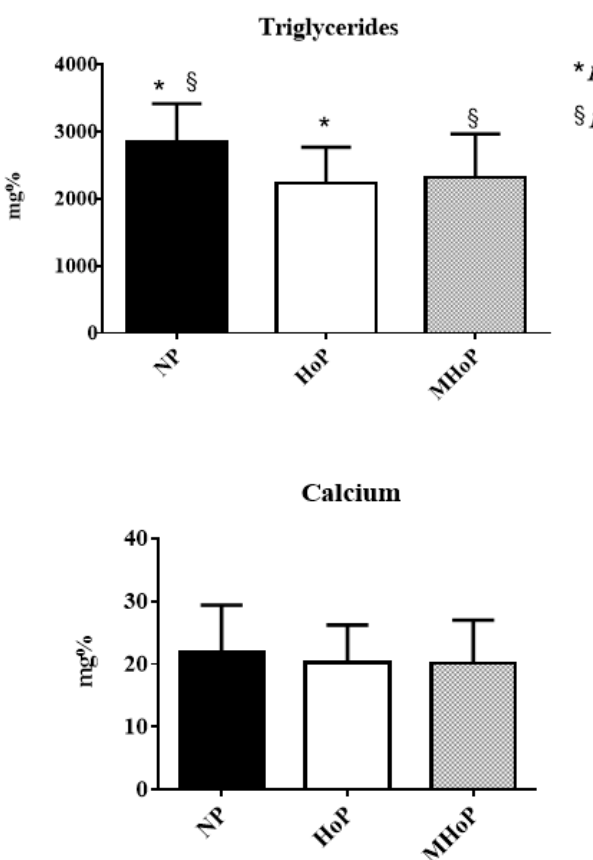
Figure 3. Triglycerides and calcium concentration in not pasteurized, pasteurized by Holder method, and pasteurized by modified Holder method aliquots. NP—not pasteurized; HoP—Holder pasteurization; MHoP—modified Holder pasteurization.